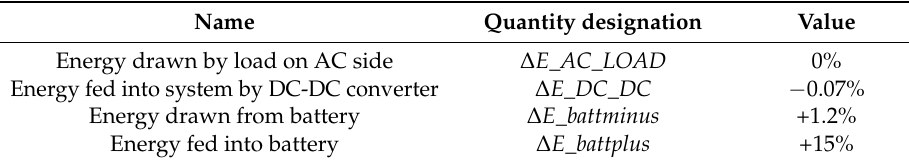
Table 4. Energy comparison during validation–percentage